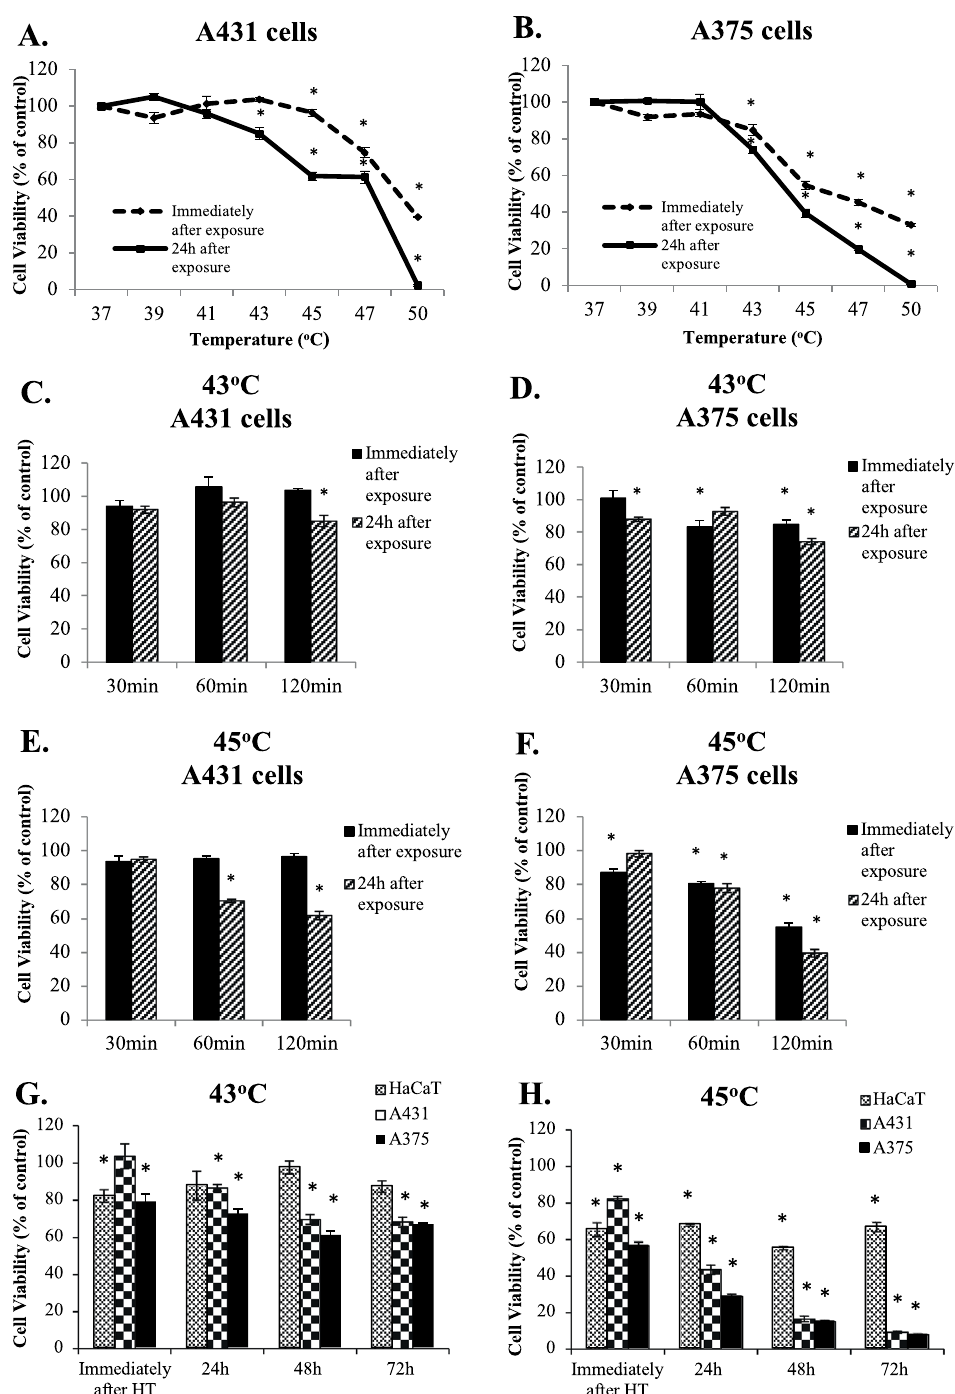
Figure 1. Kinetics of hyperthermia in human immortalized keratinocyte (HaCaT), epidermoid carcinoma (A431) and malignant melanoma (A375) cell lines. The effect of hyperthermia on cell viability levels in ( A ) A431 and ( B ) A375 cell lines; The effect of hyperthermia at different time courses in ( C and E ) A431 and ( D and F ) A375 cell lines; ( G and H ) HaCaT, A431 and A375 cell lines were subjected to hyperthermia and cell viability levels were determined immediately after as well as 24–72 h post-exposure. Data shown are mean values (n = 5) ± SEM and represent one of three independent experiments. Asterisk ( * ) indicates statistical significance at p <